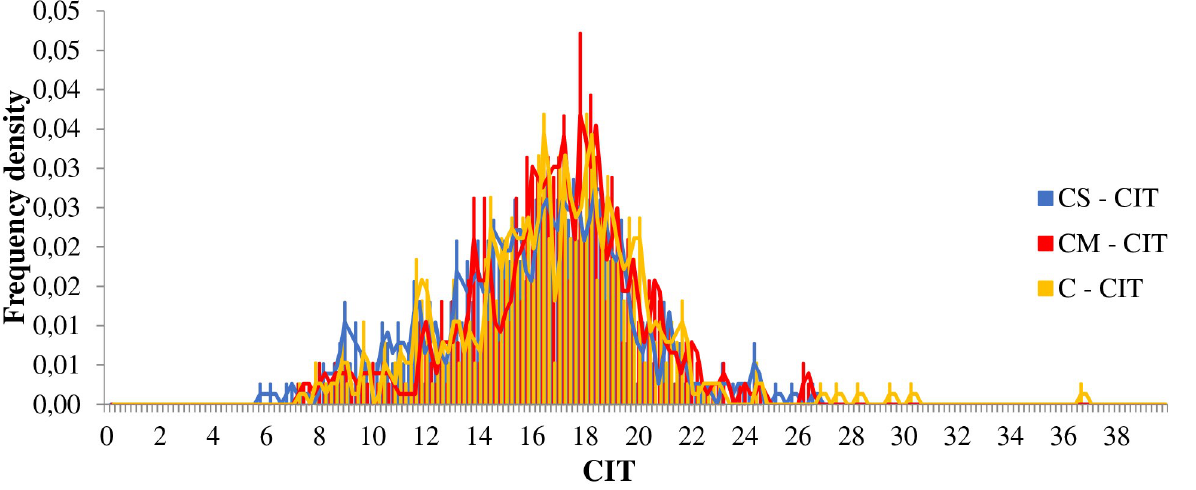
Figure 10. Histogram of CIT with trend line for cement pastes CS, CM and C.